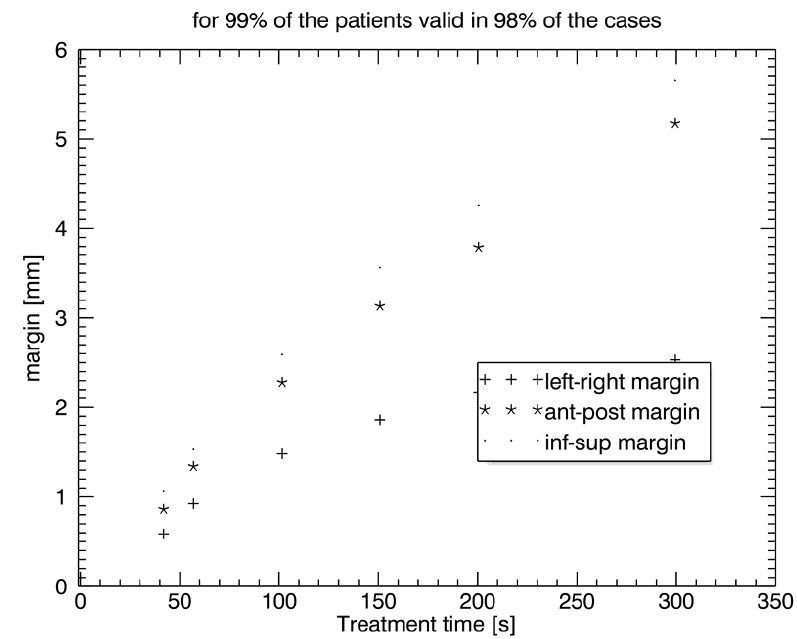
Figure 3. Comparison of the PTV safety margins in all three directions, x , y , and z , with an increasing time interval with 98% probability in 99% of the patients.